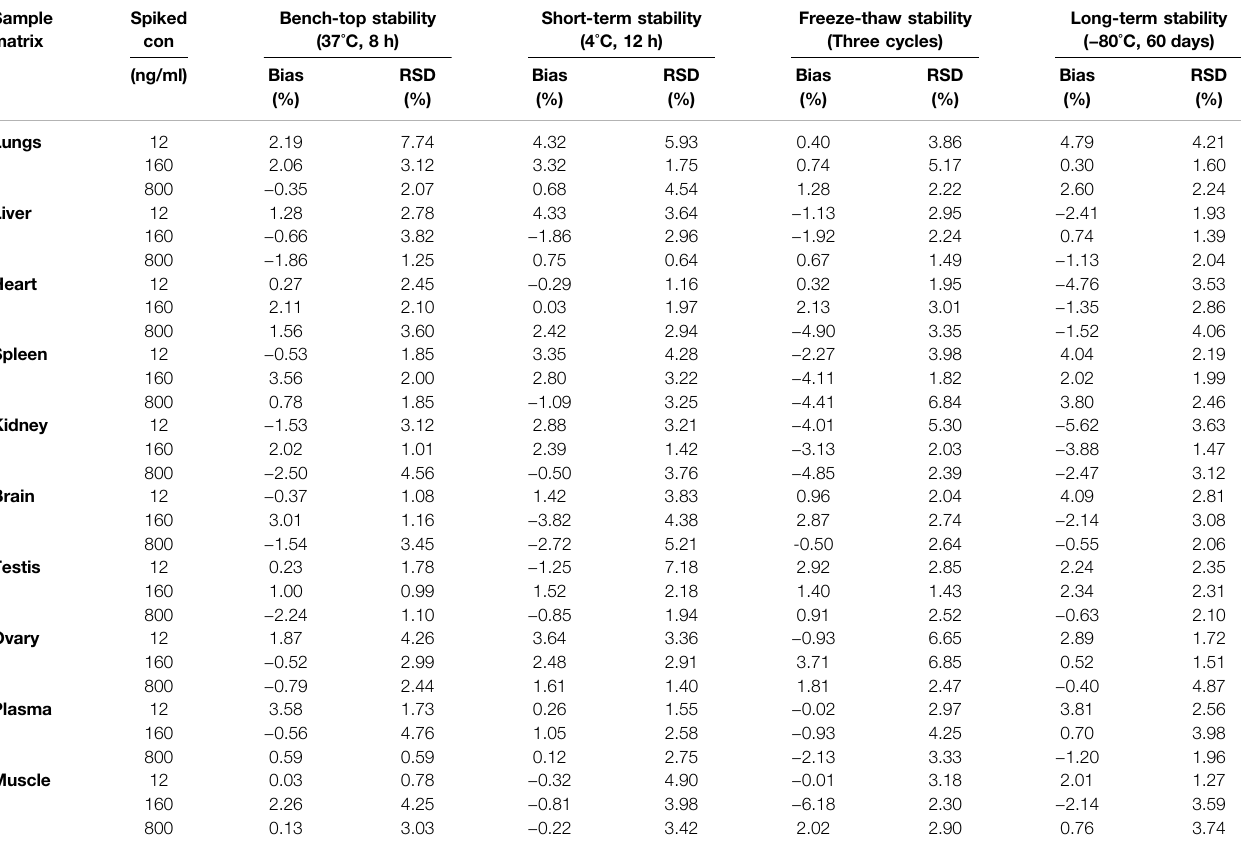
TABLE 4 | The stability of amento fl avone in rat tissue homogenates (n = 5). Sample matrix